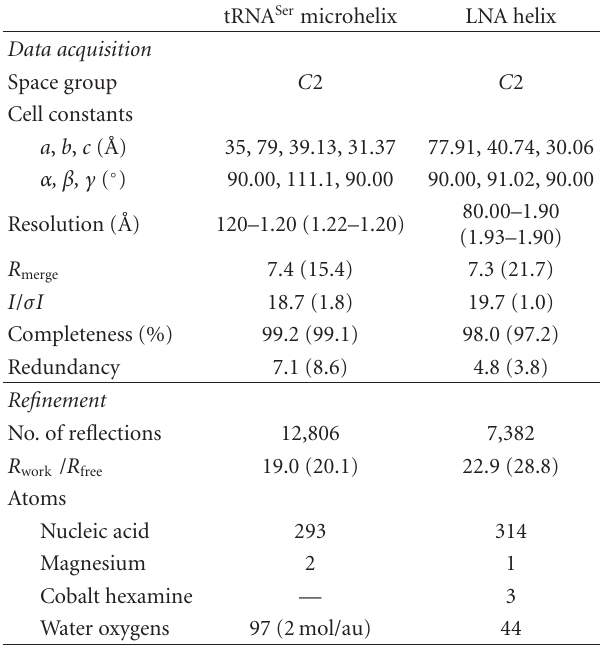
Table 1: Data and refinement statistics of tRNA Ser microhelix and LNA helix [9,